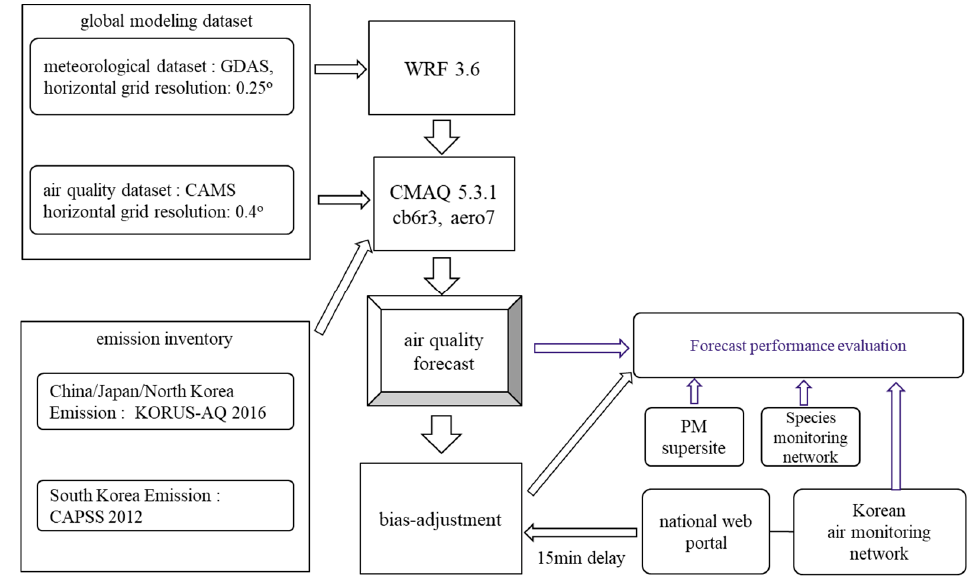
Figure 2. Schematic diagram of the